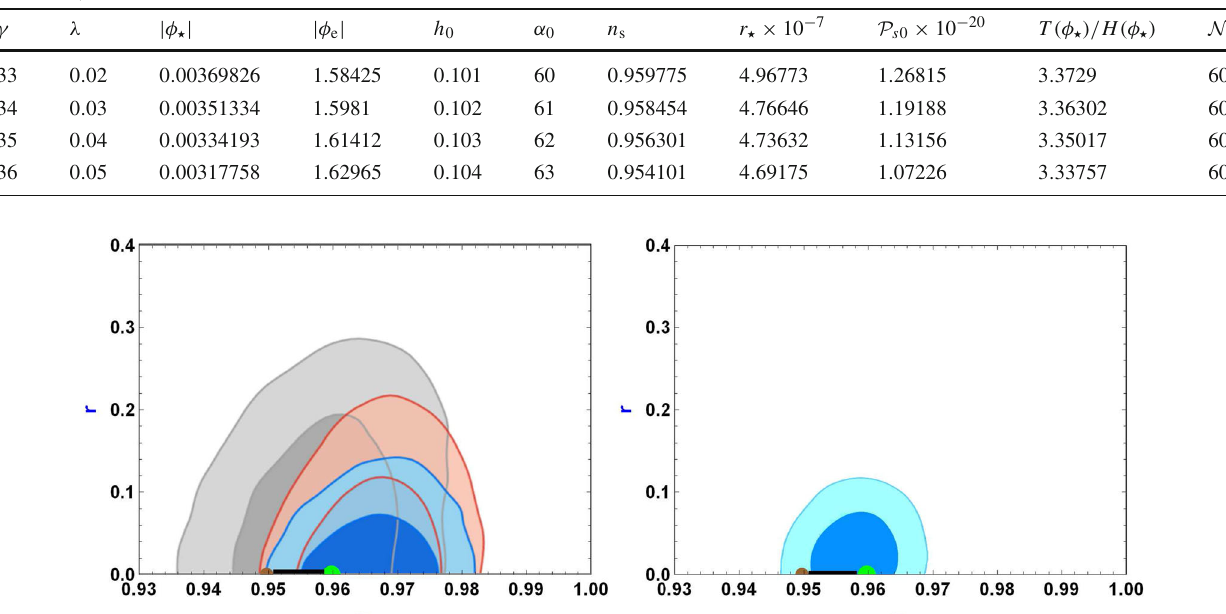
Fig. 3 The r – n s diagram comparing the predictions of the non- comoving warm inflation model in the weak regime with generalized de Sitter scale factors, having the model parameters of Table 1, with the observational data of the Planck 2013, 2015 and 2018 data sets. In the left panel, the likelihood of Planck 2013 are indicated with gray con- tours, Planck TT+lowP with red contours, and Planck TT,TE,EE+lowP